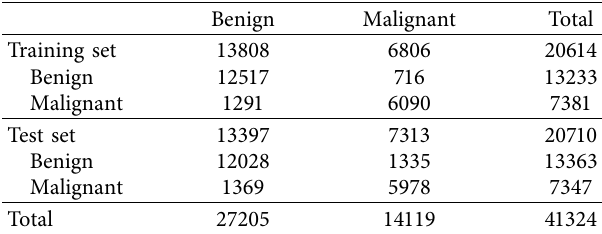
Table 4: Cross tabulation of classification results for benign and malignant cell nuclei and colloid structures by the RBF ANN for the training and test sets.